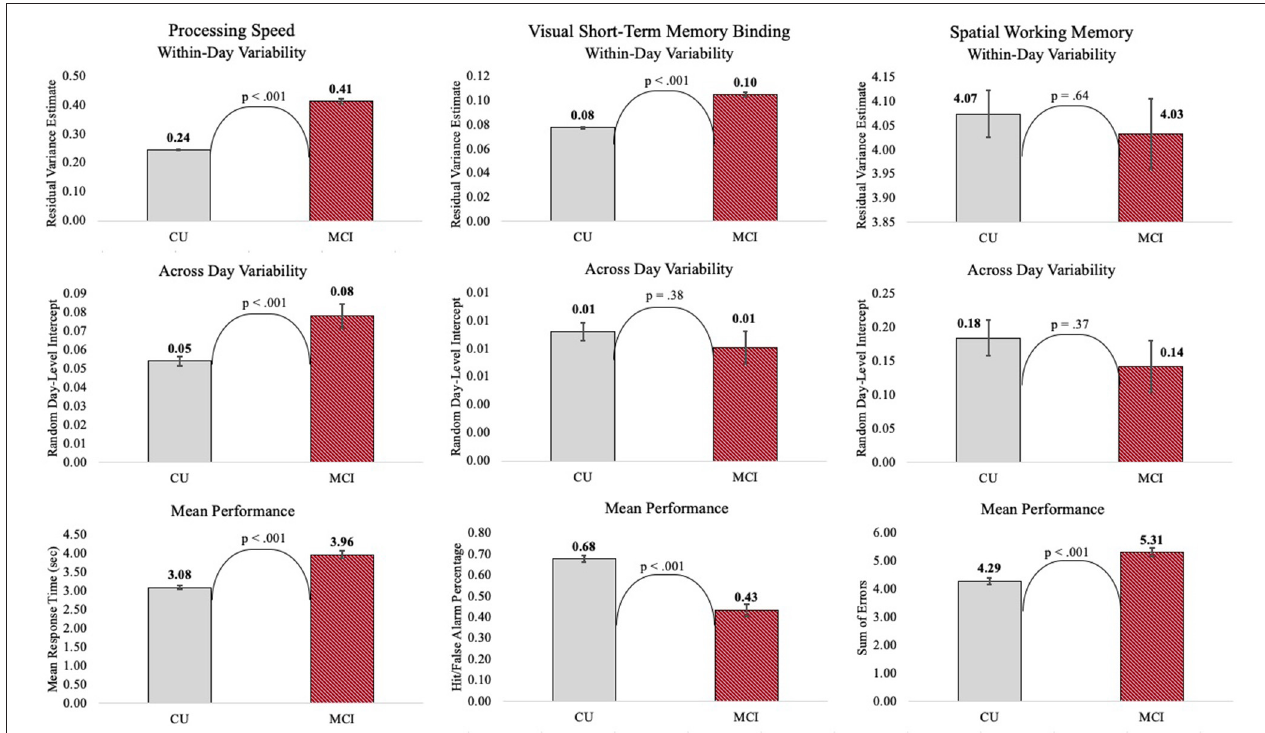
FIGURE 5 | Cognitive status differences in mean and variability in mobile cognitive